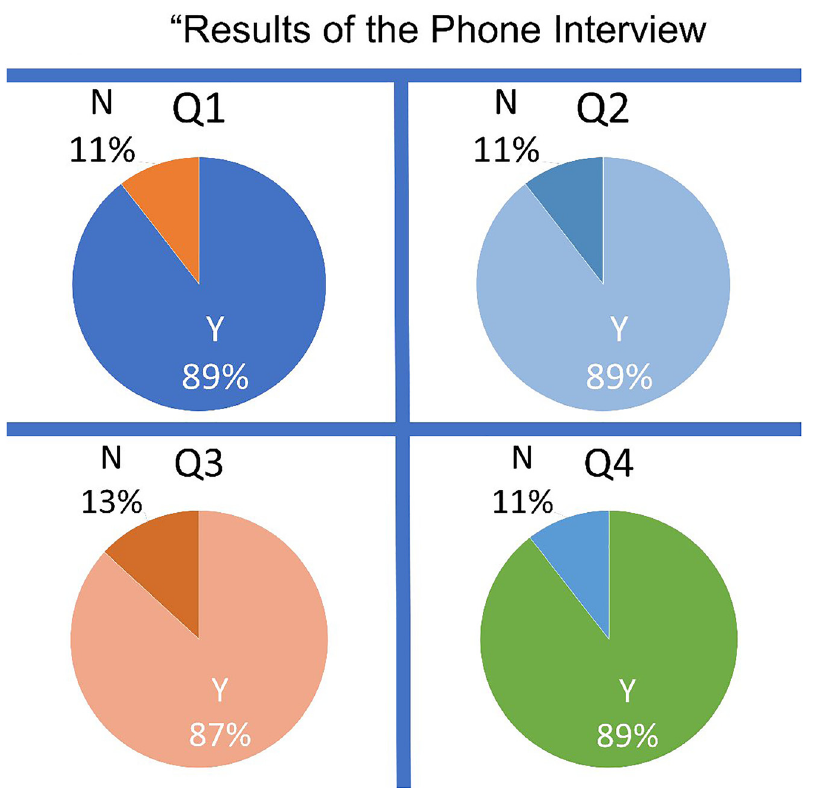
Figure 1B: Four pie charts for four yes or no questions of a phone interview about the students perception of acquired skills related to key